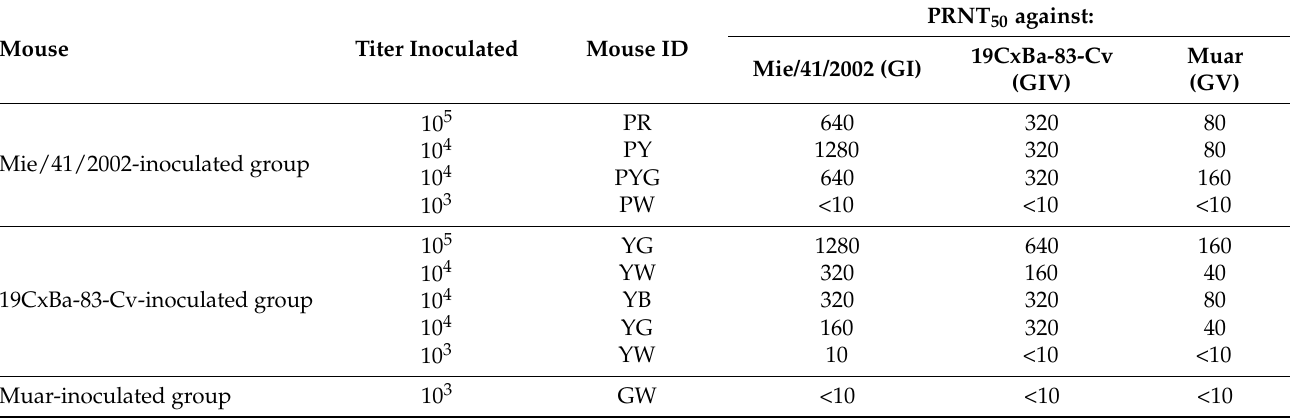
Table 1. Neutralization titers (PRNT 50 ) in sera of mice infected intraperitoneally with JEV strains Mie/41/2002, 19CxBa-83-Cv, and Muar against the JEVs 1 . Titer